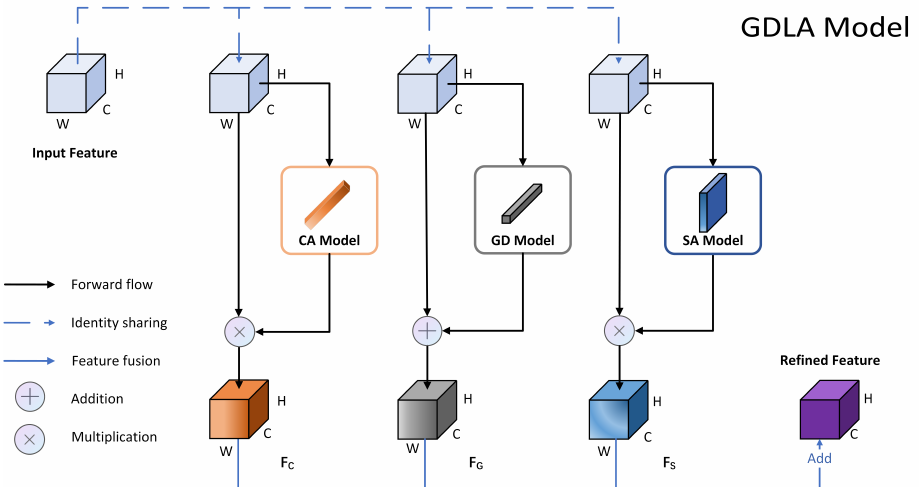
Figure 2. Overview of GDLA